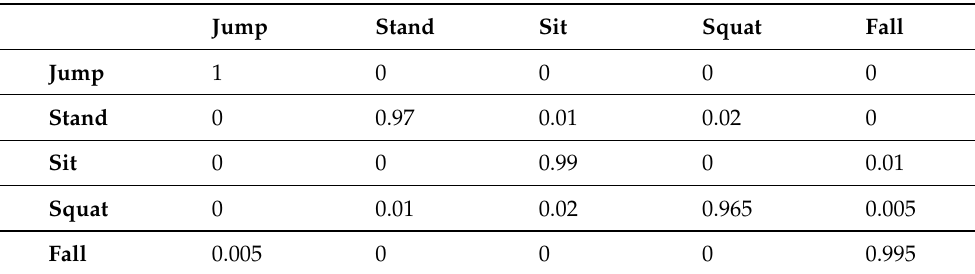
Table 2. Confusion matrix of AD.